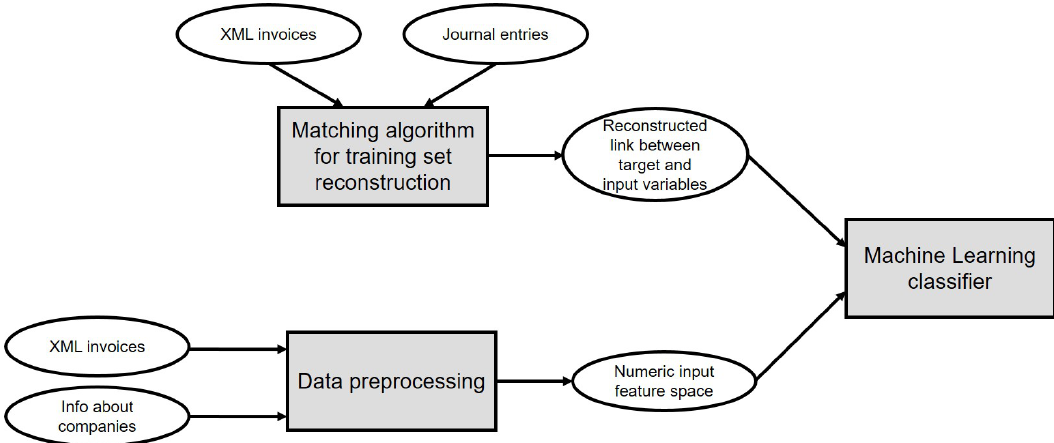
Figure 1. Methodology used in this study to process data and train a machine learning classifier. The rectangles represent the three methodological steps, while the circles contain input/output elements of the building